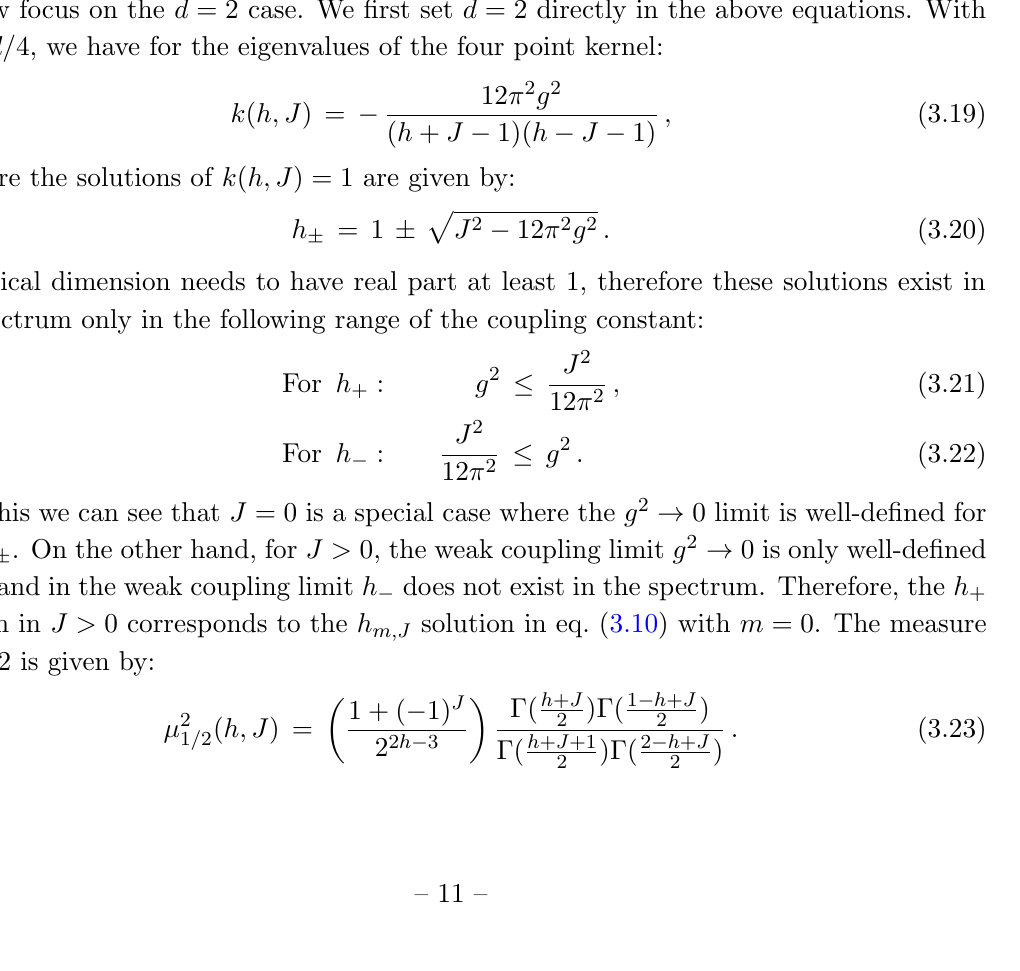
1 for d = 3, g = 0 : 1 i , and J = 0 ; 2 ; (cid:0)